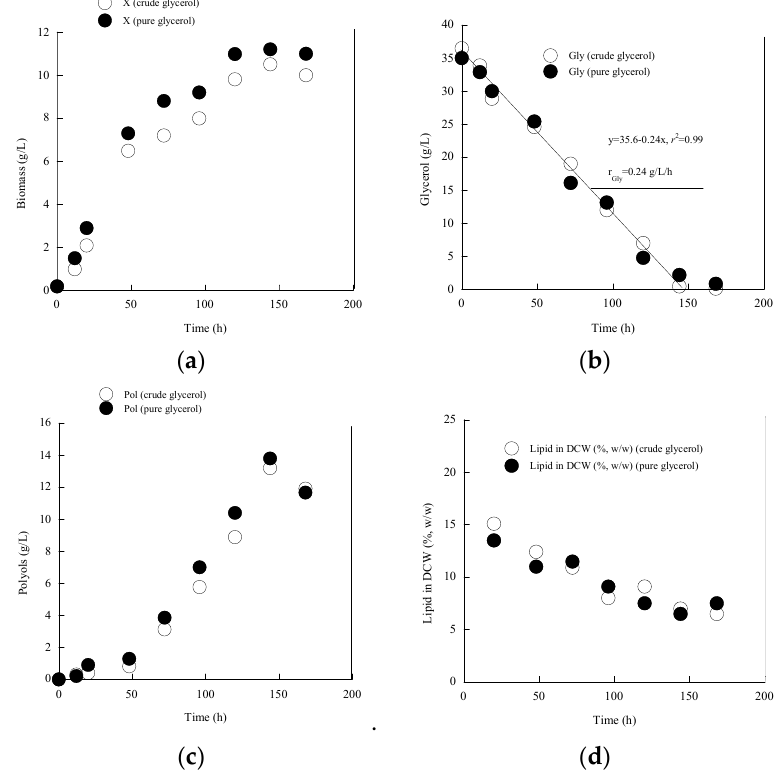
Figure 1. Kinetics of dry yeast cell mass production ( X , g/L) ( a ), glycerol assimilation ( Gly , g/L) ( b ), total polyols synthesis ( Pol , g/L) and ( c ) lipid in dry cell weight (%, w/w ), ( d ) by Yarrowia lipolytica LMBF Y-46, during growth on pure and biodiesel-derived glycerol in shake-flask experiments under nitrogen-limited conditions. Culture conditions: growth in 250 mL conical flasks at 180 ± 5 rpm, initial pH = 6.0 ± 0.1, pH ranging between 4.5 and 6.1, incubation temperature T = 28 ± 1 °C. Each experimental point is the mean value of two independent determinations (SE ≤ 18%).